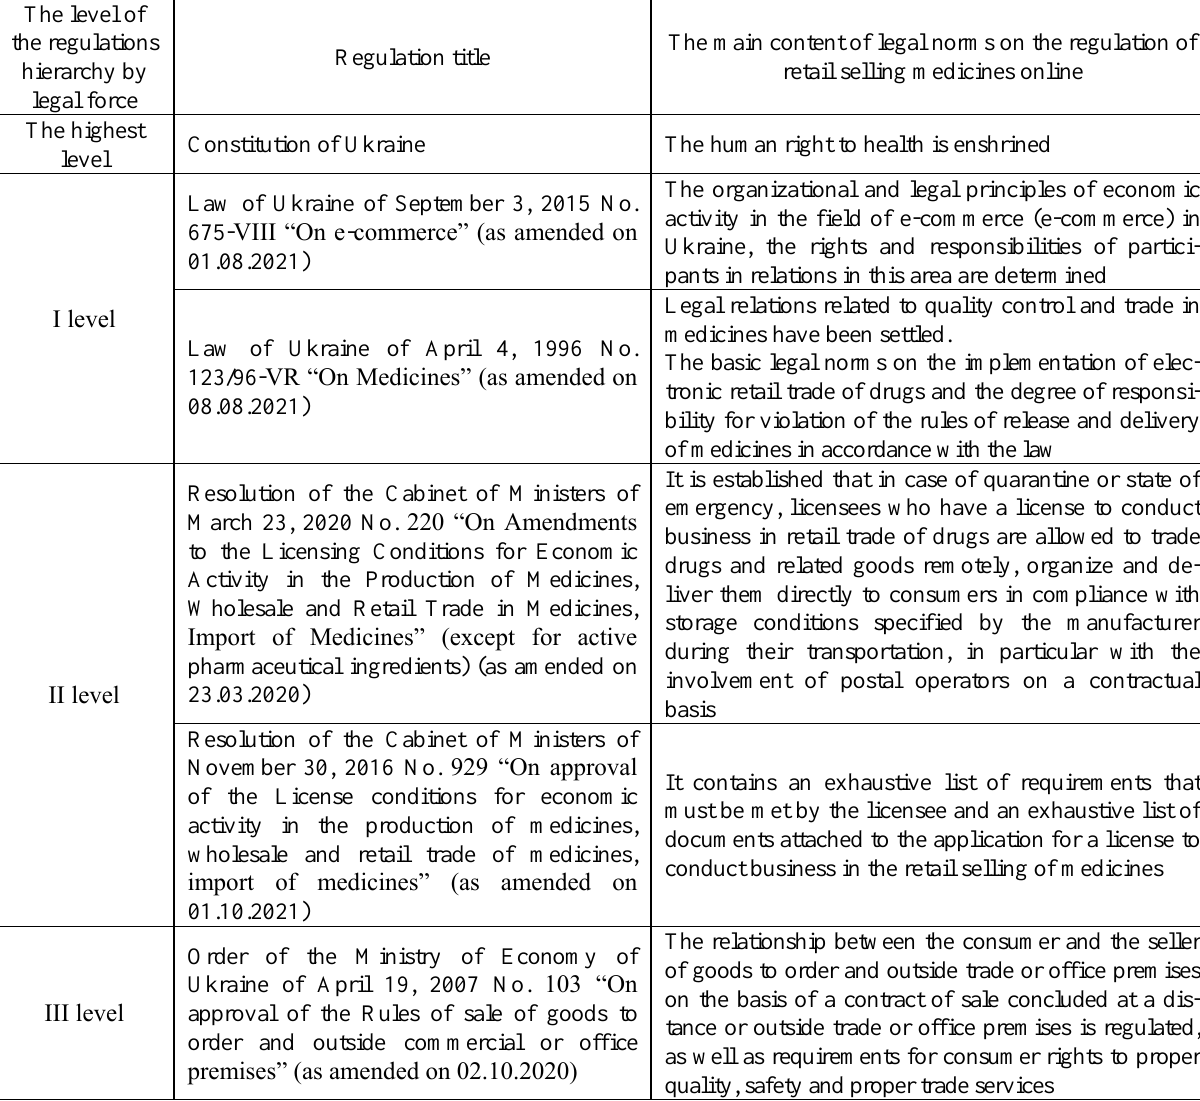
The results of generalization of the provisions of the regulations of Ukraine on the regulation of the online retail